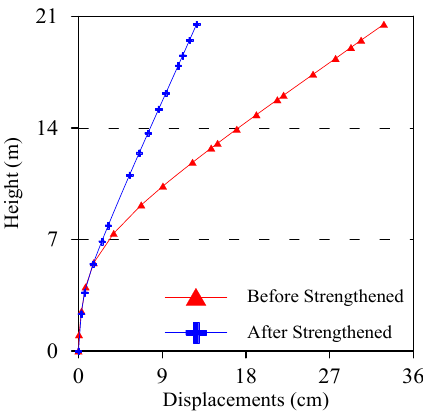
Fig. 8. Variation of maximum displacements along to the height of the minaret at the time of maximum response before and after FRP composite strengthening.